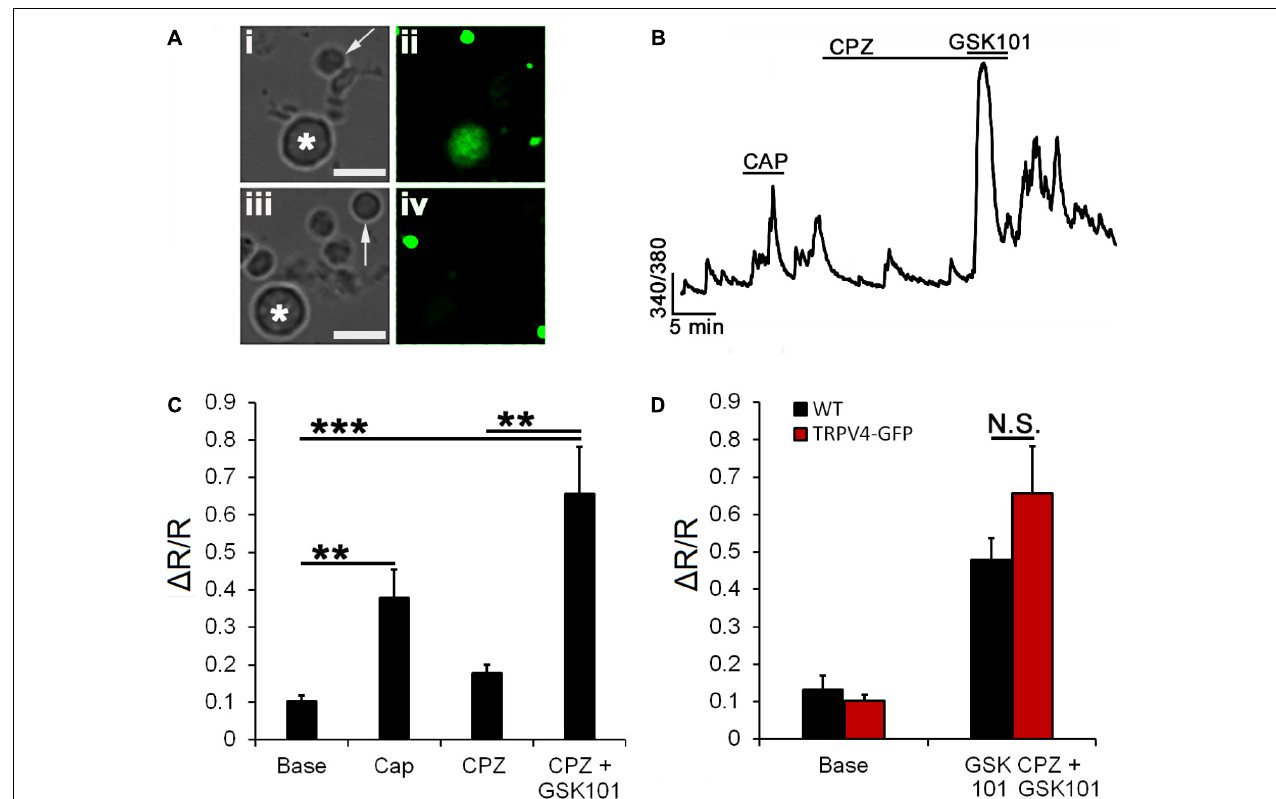
FIGURE 6 | TRPV4 signaling does not require TRPV1. (A) Cells dissociated from transgenic TRPV4 GFP retinas (i,ii) and control retinas (iii,iv) show reporter expression in large-diameter neurons (asterisk) but not rod somata (arrow). (B) Representative trace from a TRPV4 GFP + RGC shows a potential response to CAP superimposed on spontaneous background Ca 2 + transients. The TRPV1 antagonist CPZ (10 µ M) did not affect the [Ca 2 + ] i baseline or inhibit GSK101-evoked [Ca 2 + ] i elevations. (C) Averaged data for CAP and CPZ responses in TRPV4 GFP + RGCs ( n = 12). (D) CPZ had no effect on the amplitude of GSK101-evoked [Ca 2 + ] i signals ( n = 12). Scale bar = 10 µ m. N.S., P < 0.05, ∗∗ P ≤ 0.01, ∗∗∗ P ≤